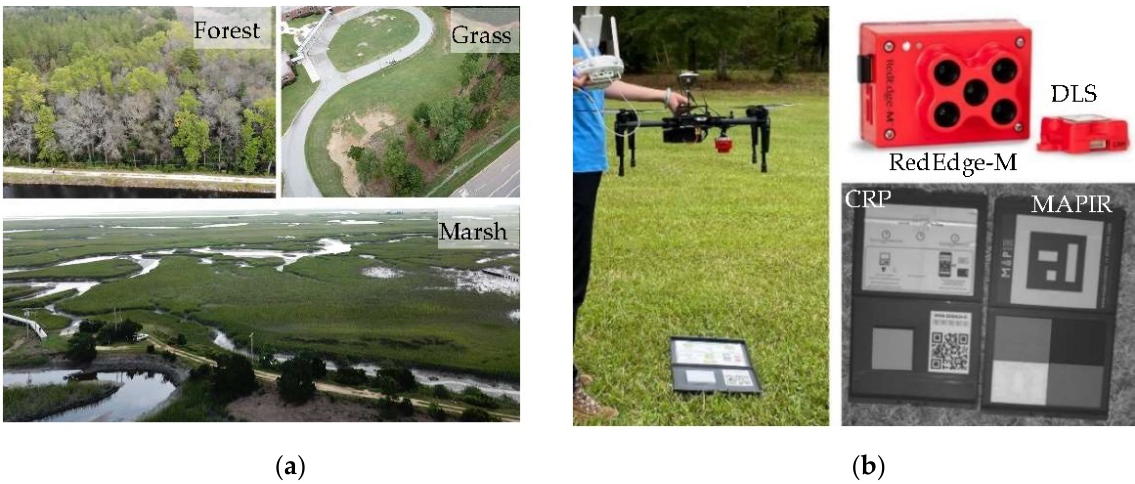
Figure 1. The oblique view of the three sites (forest, grass, marsh) ( a ) and the RedEdge-M camera mounted at the bottom of M100 and the two panels ( b ). The DLS is on the top of drone. Two calibration boards, MicaSense CRP and MAPIR panels (black/dark grey/light grey/white), are used in the study.